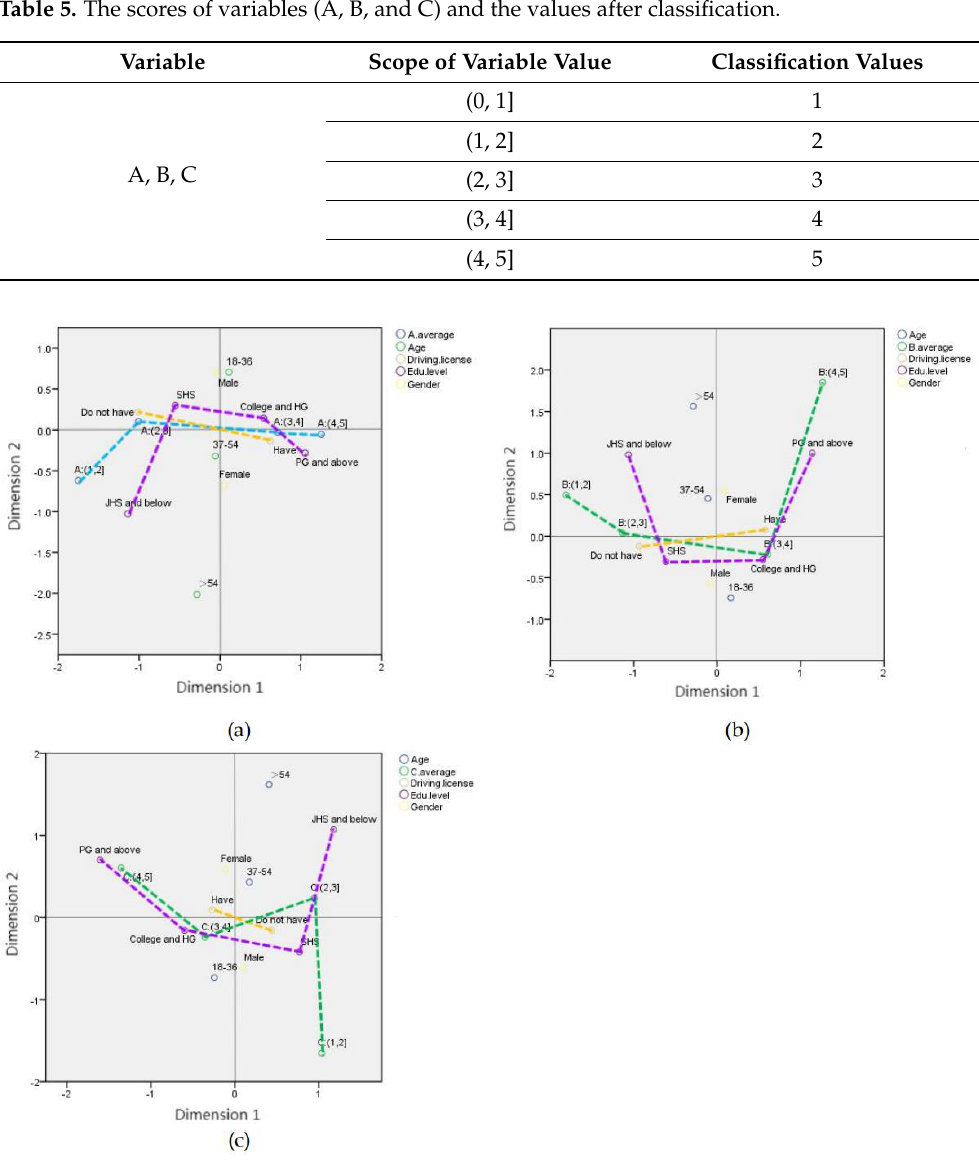
Figure 4. Joint plot of the category points. Correspondence between the variables: ( a ) The corre- spondence between the public’s characteristics and variable A; ( b ) the correspondence between the public’s characteristics and variable B; and ( c ) the correspondence between the public’s characteristics and variable C. The education level in the figures is abbreviated (JSH and below stands for junior high school and below; SHS stands for senior high school; college and HG stands for college and undergraduate; PG and above stands for postgraduate and above).